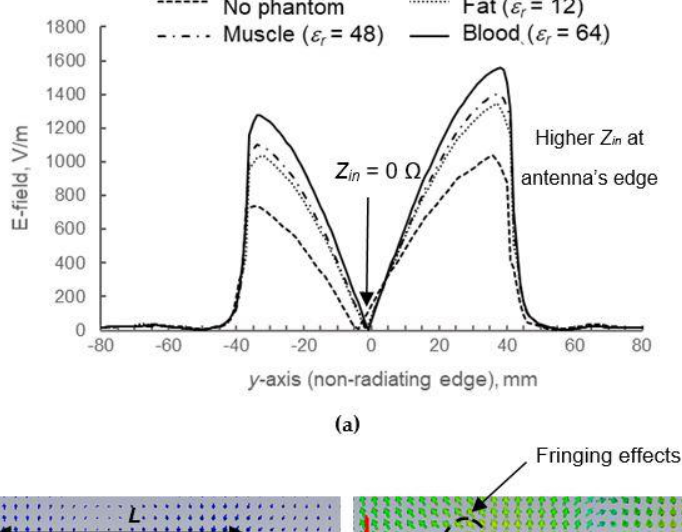
Materials 2019 , 12 , x FOR PEER REVIEW 13 of 17